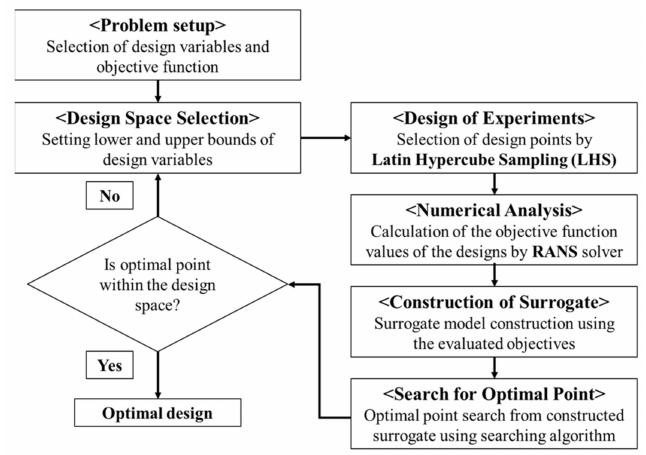
Figure 4. Single-Objective optimization process.